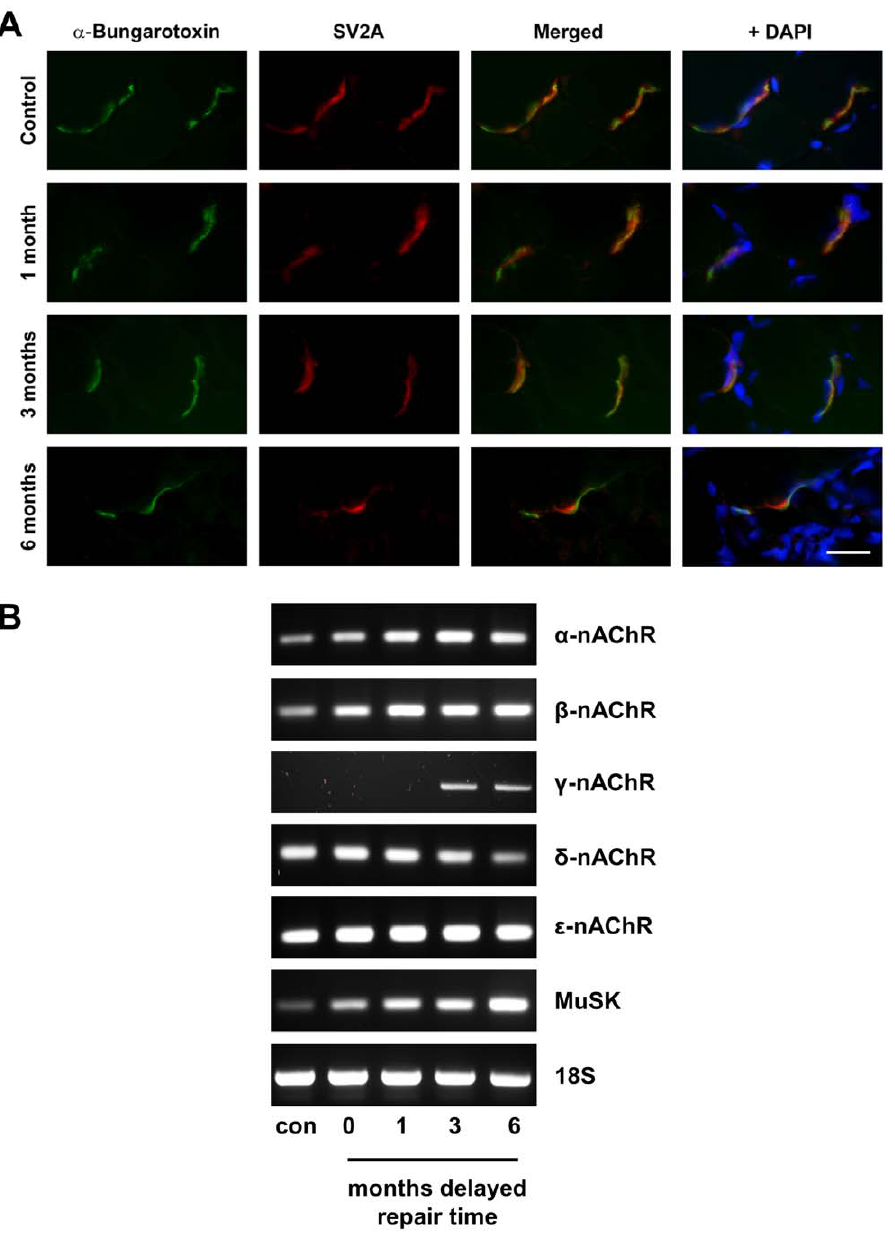
Figure 9. Neuromuscular junctions and expression of nicotinic acetylcholine receptors (nAChRs). (A) Muscle sections were stained for nAChRs with a -bungarotoxin-FITC (green) and with SV2A antibody (red) to mark pre-synaptic structures. Note the coincident staining of both markers indicating presumptive functional NMJs. DAPI staining (blue) shows nuclei. Scale bar=25 m m. (B) RT-PCR analysis of the different nAChR subunits ( a , b , c , d , e ) and muscle specific kinase MuSK in control muscle (con) and muscle from the operated side of animals undergoing immediate (0) or 1,3,6 months delayed nerve repair. 18 S was used as a house-keeping gene.